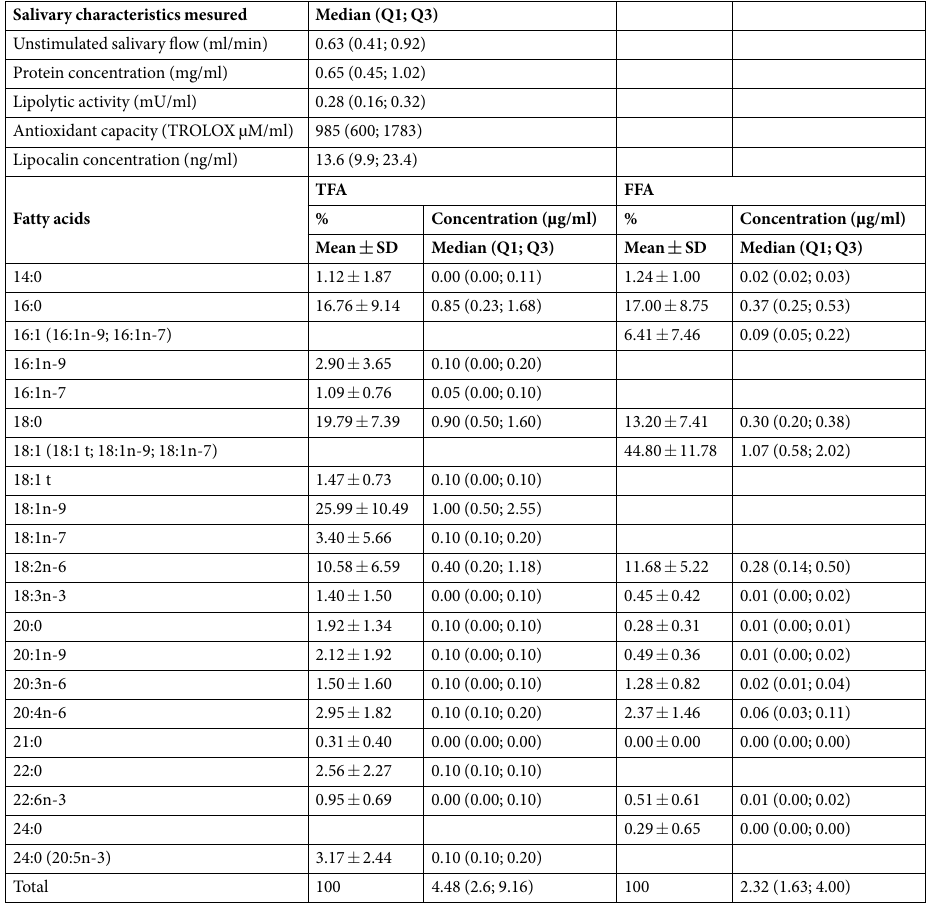
Table 2. Characteristics of unstimulated saliva collected on 54 subjects. Free fatty acids 16:1 and 18:1 are presented as the sum of their isomers since GC-MS does not distinguish them. 24:0 and 20:5n-3 cannot be separated by GC-FID. Fatty acids composition for TFA and FFA is expressed in the mean ± SD relative percentage of each fatty acid among all the fatty acids detected and in the median (Q1, first quartile; Q3, third quartile) of the concentration of each fatty acid ( µ g/ml of